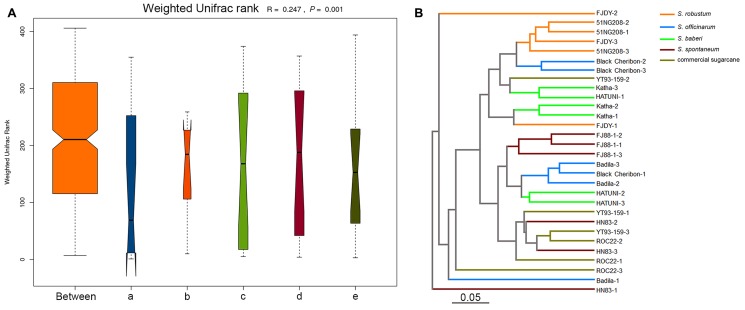
Beta-diversity analysis showing variation in the bacterial communities in different sugarcane species. The variation between different sugarcane species using ANOSIM and cluster analysis. (A) Analysis of similarity (ANOSIM) is a statistical test of the variation in microbial community composition, and the difference between the five sugarcane species was significantly greater than those in the group (R = 0.247, P = 0.001). (a) S. officinarum; (b) S. barberi; (c) S. robustum; (d) commercial cultivars; (e) S. spontaneum. (B) Unweighted pair group method with arithmetic mean (UPGMA) was used to form an evolutionary tree.